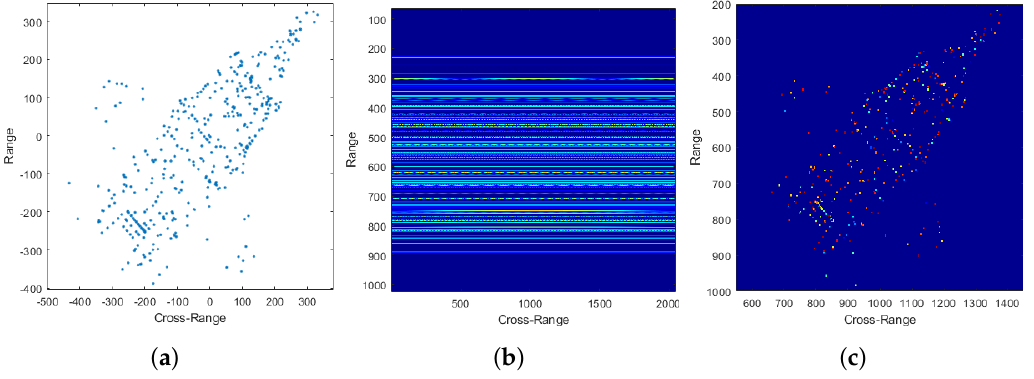
Figure 4. ( a ) Simulated F35 Plane Model, ( b ) Full echo data and ( c ) ideal ISAR